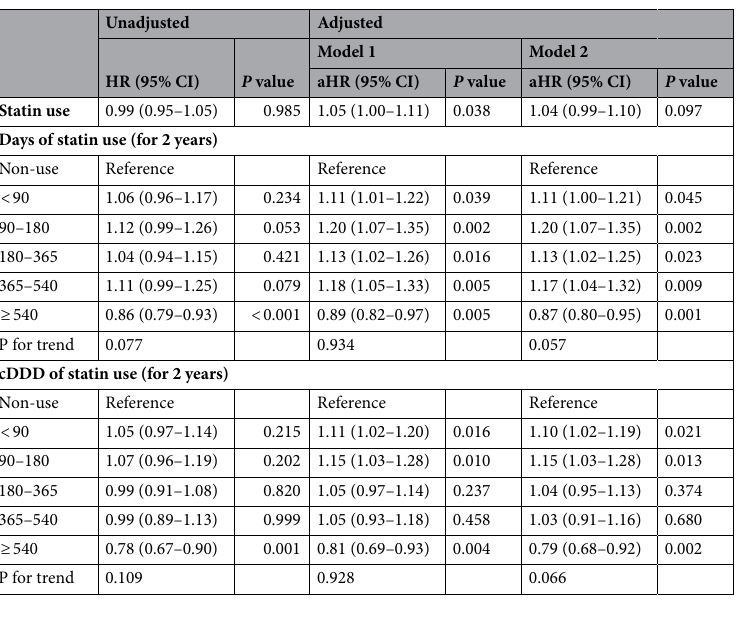
Table 2. Association of statin use with incidence of Alzheimer’s disease. cDDD cumulative defined daily dose, HR hazard ratio, aHR adjusted hazard ratio, CI confidence interval. Model 1 was adjusted for age and sex. Model 2 was adjusted for model 1 + body mass index, income, smoking status, alcohol status, hypertension, diabetes, and baseline cholesterol level.